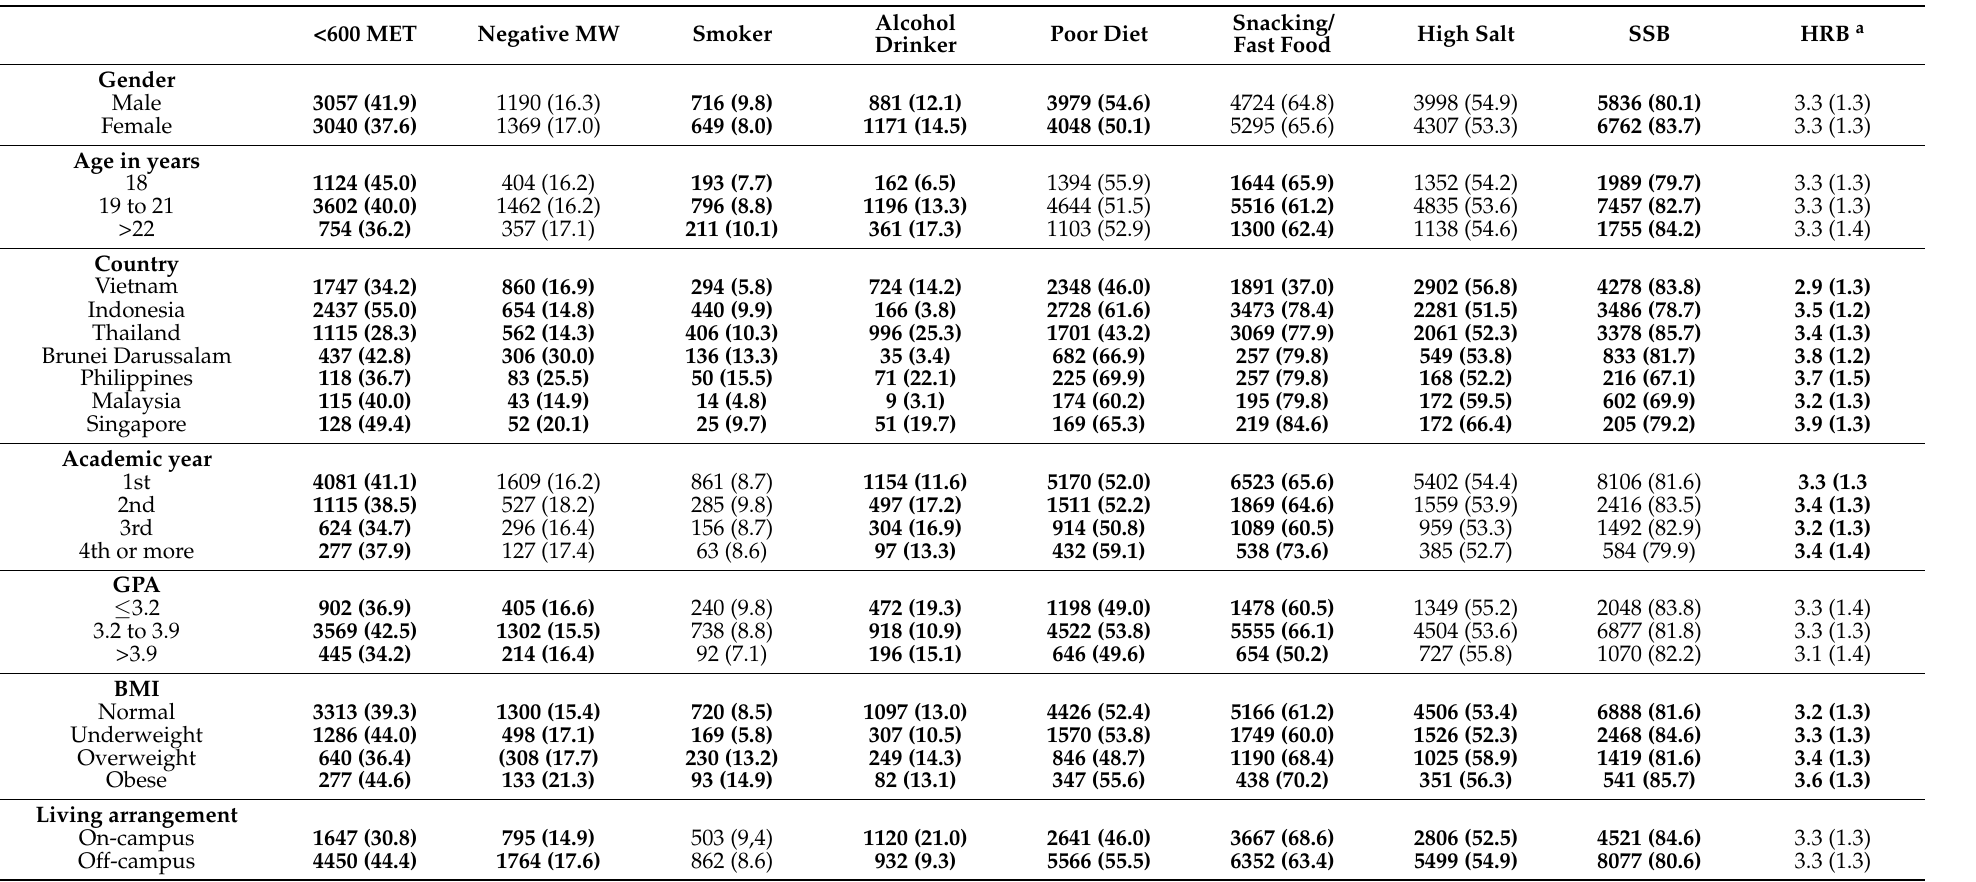
Table 3. Sociodemographic factors associated with health-risk behaviors using chi-square test ( n = 15,366) (Frequency